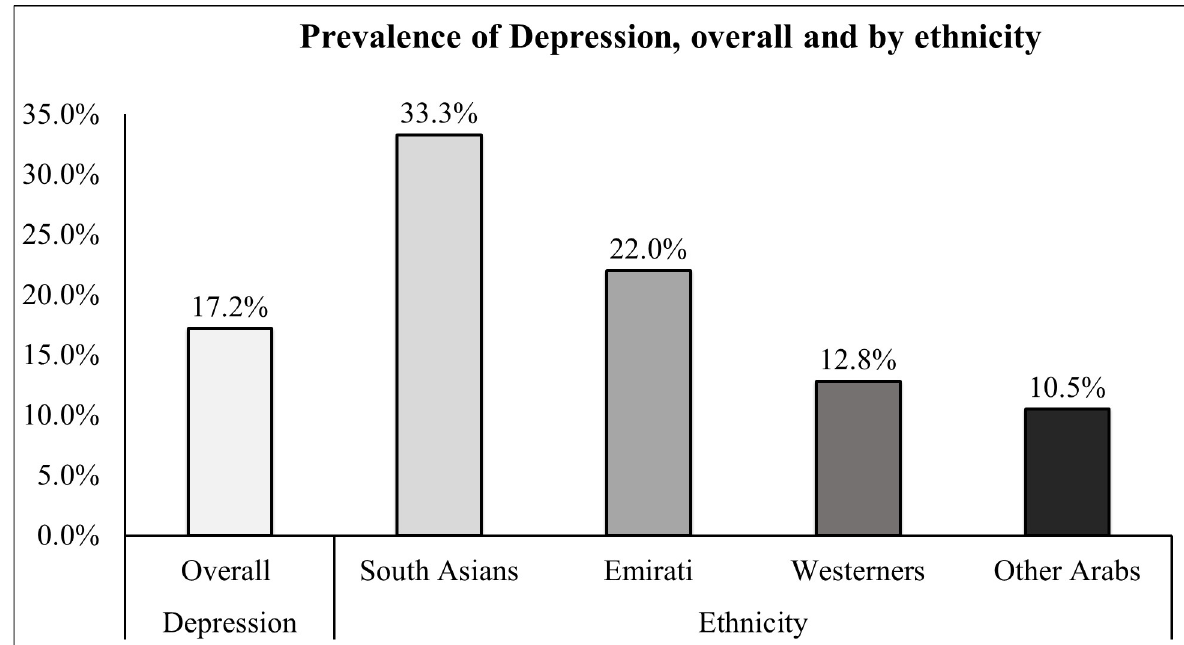
Fig 1. Prevalence of depressive symptoms among adolescents by